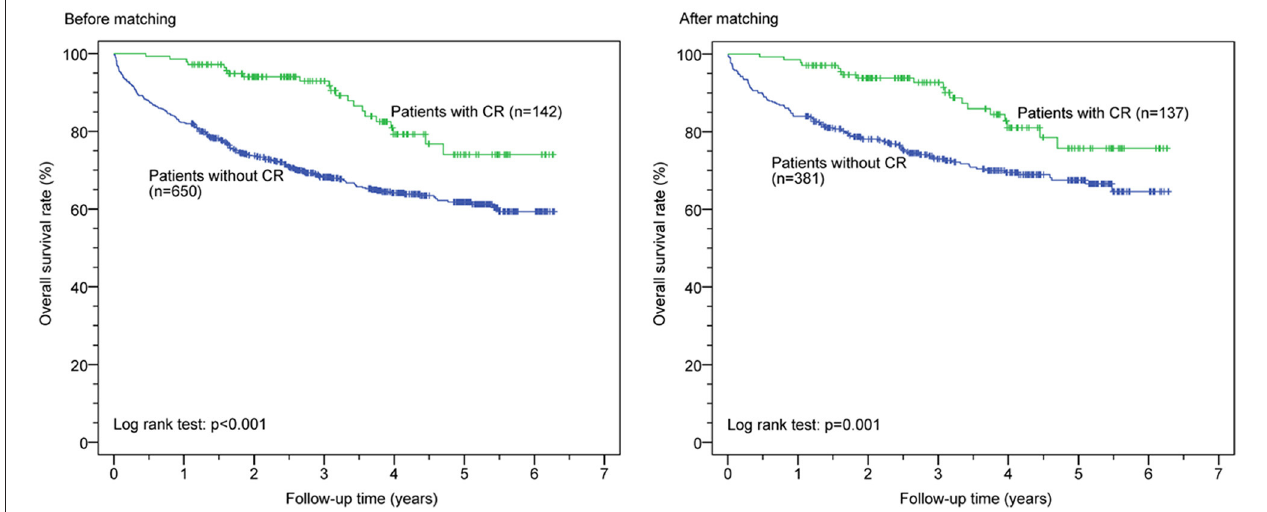
FIGURE 1 | Cardiac rehabilitation (CR) and all-cause mortality before and after propensity score matching.